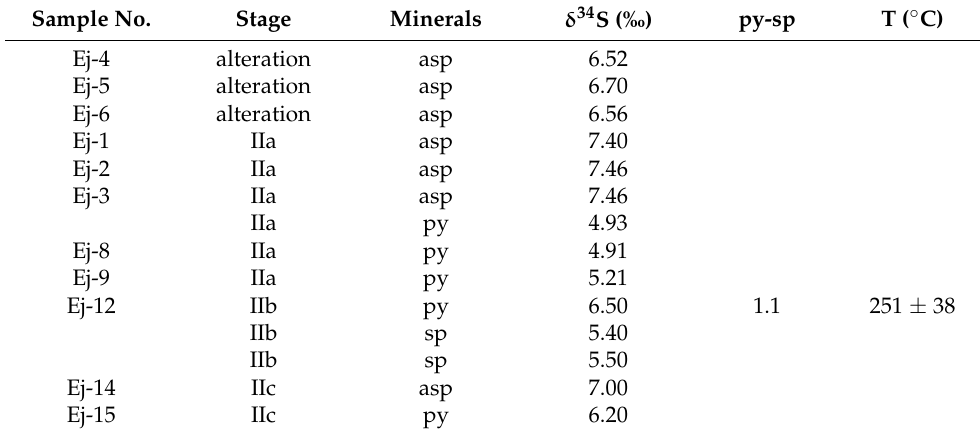
Table 6. Sulfur isotope data from the Eunjeok Au–Ag deposit. Sample No.